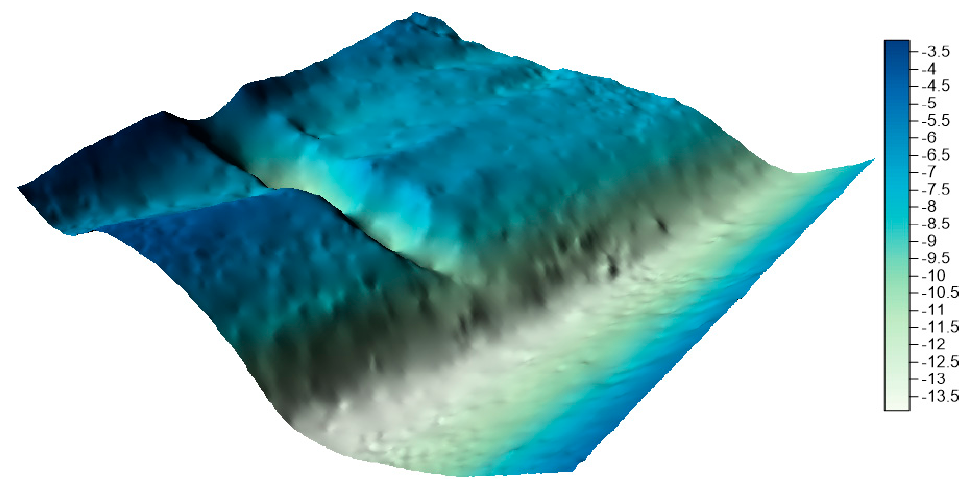
Figure 16. Surface obtained by integrated dataset no. 2 for the Inski canal area.